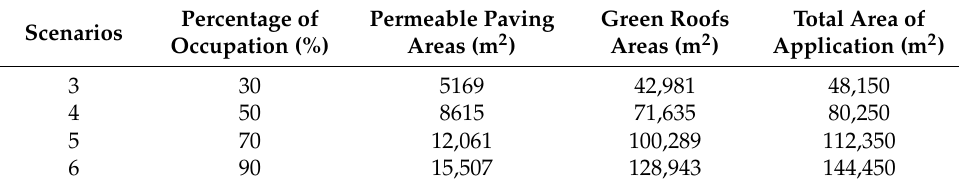
Table 5. Occupation areas for different simulated